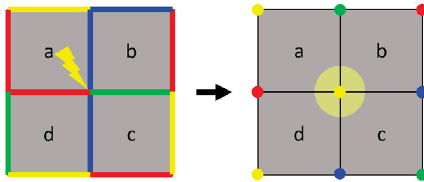
Fig. 10 Tiles incompatible at common corner despite compatible edges, solved by enforcing common corners.